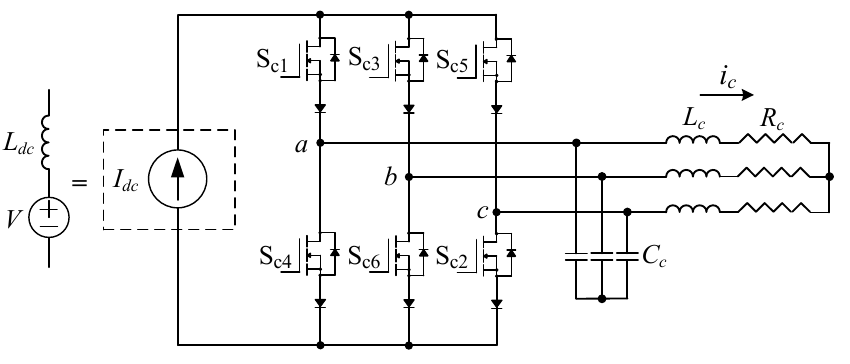
Figure 31. Three-phase CSI.